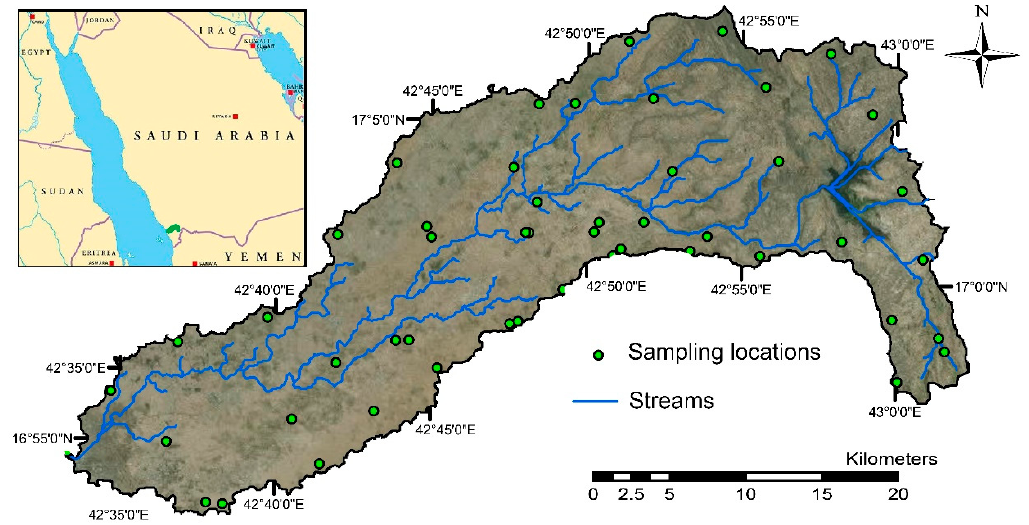
Figure 1. Study area and soil sampling locations in the Jazan watershed.